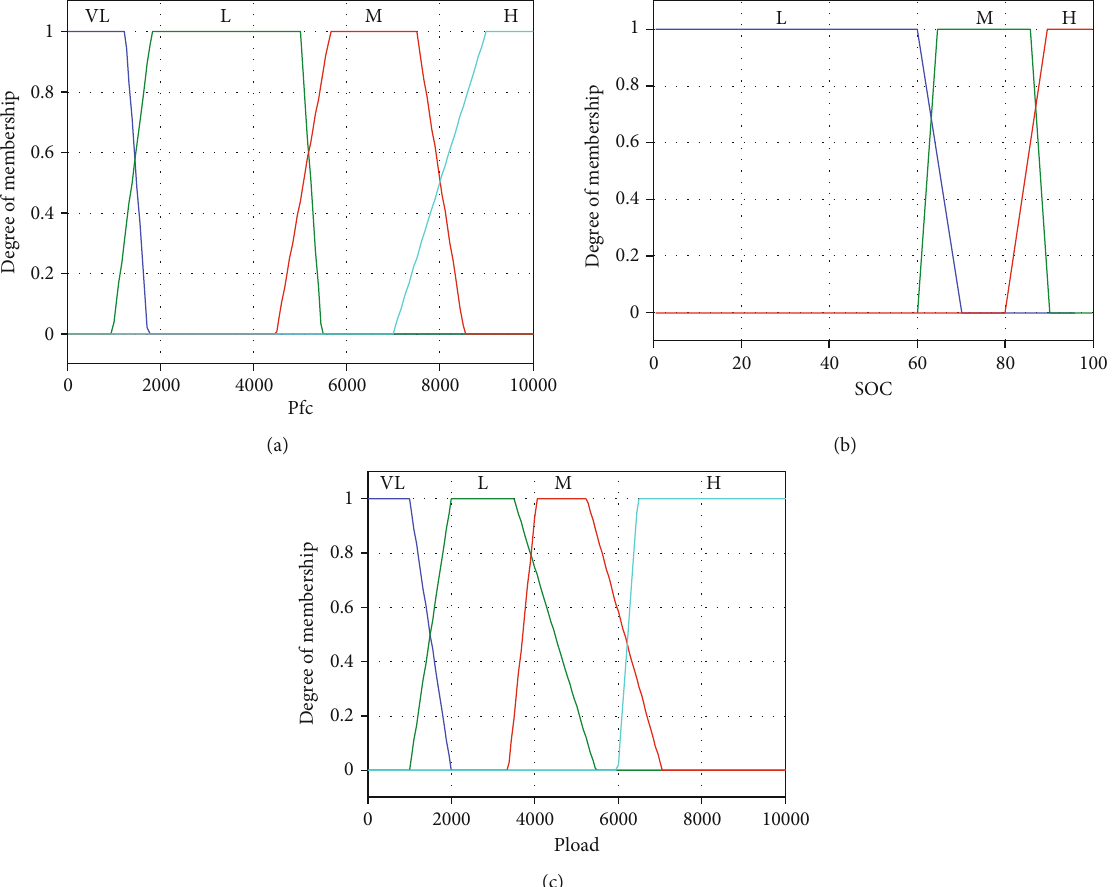
Figure 9: (a) Input 1 membership functions. (b) Input 2 membership functions. (c) Output membership